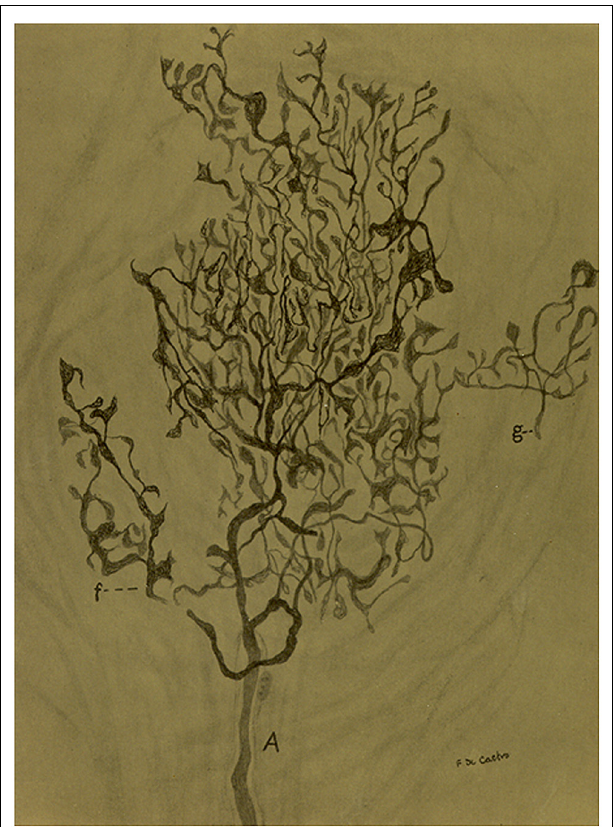
FIGURE 5 | Sensory ending in a tangential section in the carotid sinus of a man. (A)Thick myelinated axon that arborises in a rather beautiful pattern with different details in the terminals. (f) A branch of the main fiber. (g) Nerve terminal in racket.The preparation was stained by the Cajal’s reduced silver nitrate method (in de Castro, 1928; courtesy of Fernando-Guillermo de Castro from the Archive Fernando de